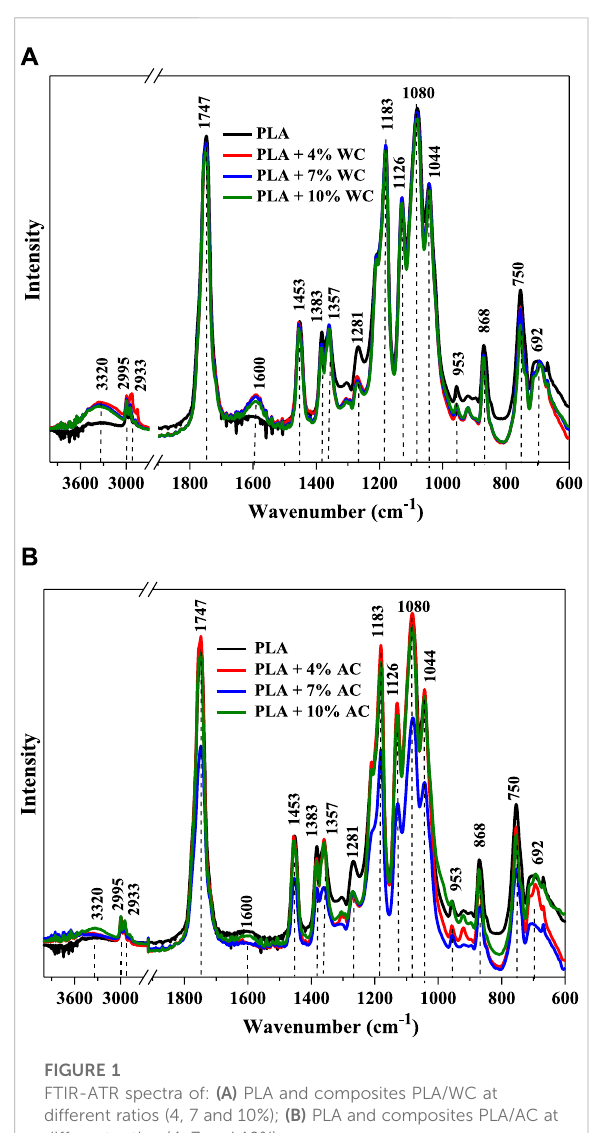
FIGURE 1 FTIR-ATR spectra of: (A) PLA and composites PLA/WC at different ratios (4, 7 and 10%); (B) PLA and composites PLA/AC at different ratios (4, 7 and